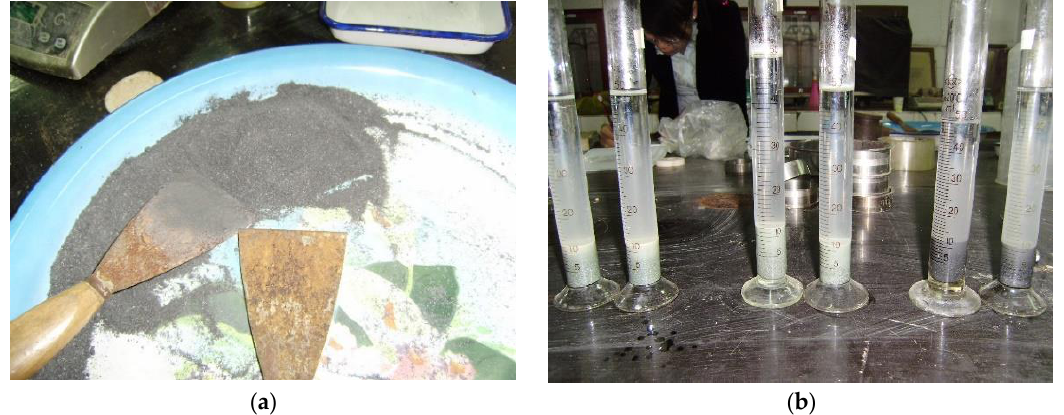
Figure 4. ( a ) Sample crushing; ( b ) free expanding rate test.